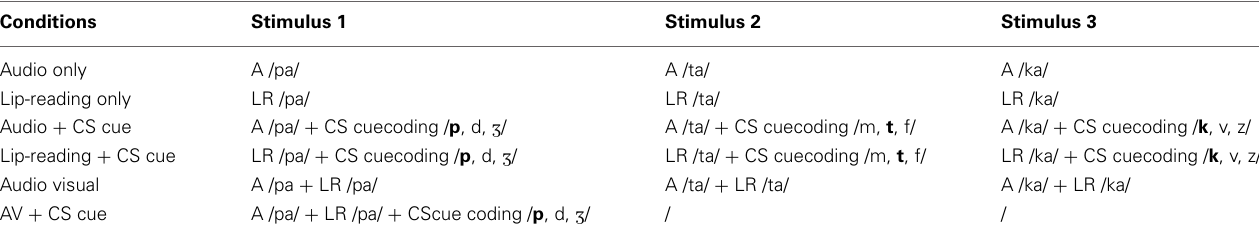
Table 2 | Stimulus composition of congruent control conditions.